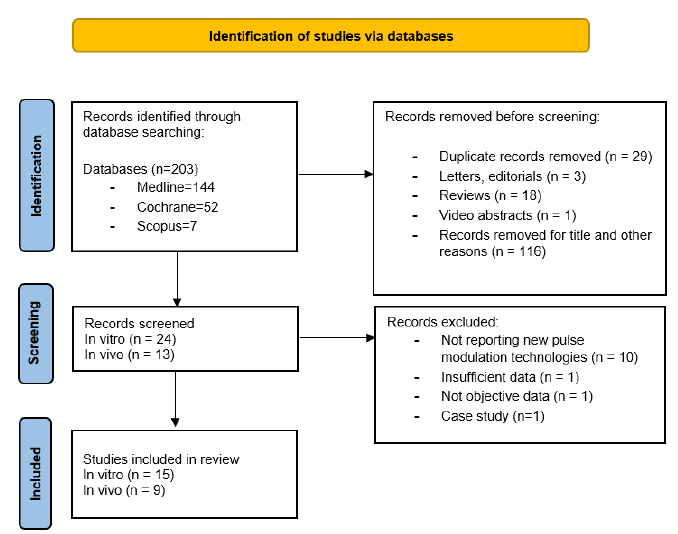
Figure 1. PRISMA (preferred reporting items of systematic reviews) flow diagram of study inclusion process.